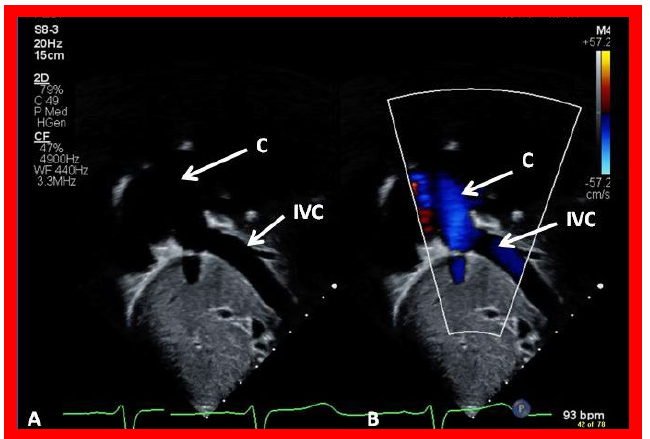
Figure 46. Selected video frame demonstrating wide open conduit (COND) by 2D ( A ), and color flow imaging ( B ). Note laminar flow in ( B ) indicating no obstruction.